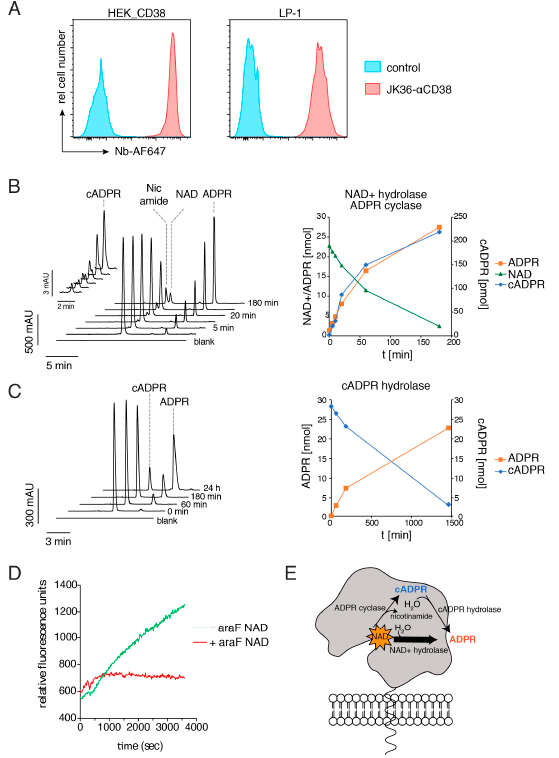
Figure 1. CD38-expressing tumor cells display potent NAD + hydrolase activity and weak ADPR cyclase and cyclic-ADPR hydrolase activities. ( A ) HEK cells stably transfected with human CD38, untransfected HEK cells, and human LP-1 multiple myeloma cells were analyzed for cell surface levels of CD38, by incubation with Alexa647-conjugated CD38-specific nanobody JK36, before analysis by flow cytometry. ( B,C ) LP-1 cells were incubated at 37 °C in the presence of 500 μ M NAD + (b) or cADPR + (c). The reaction was stopped at the indicated time points and NAD + and its metabolites were quantified using reversed-phase HPLC. ( D ) LP-1 cells were incubated at 37 °C with 50 μ M NGD + and fluorescence intensity (ex/em: 300/410 nm) was determined using a microplate reader. ( E ) Schema summarizing the enzyme activities catalyzed by CD38.